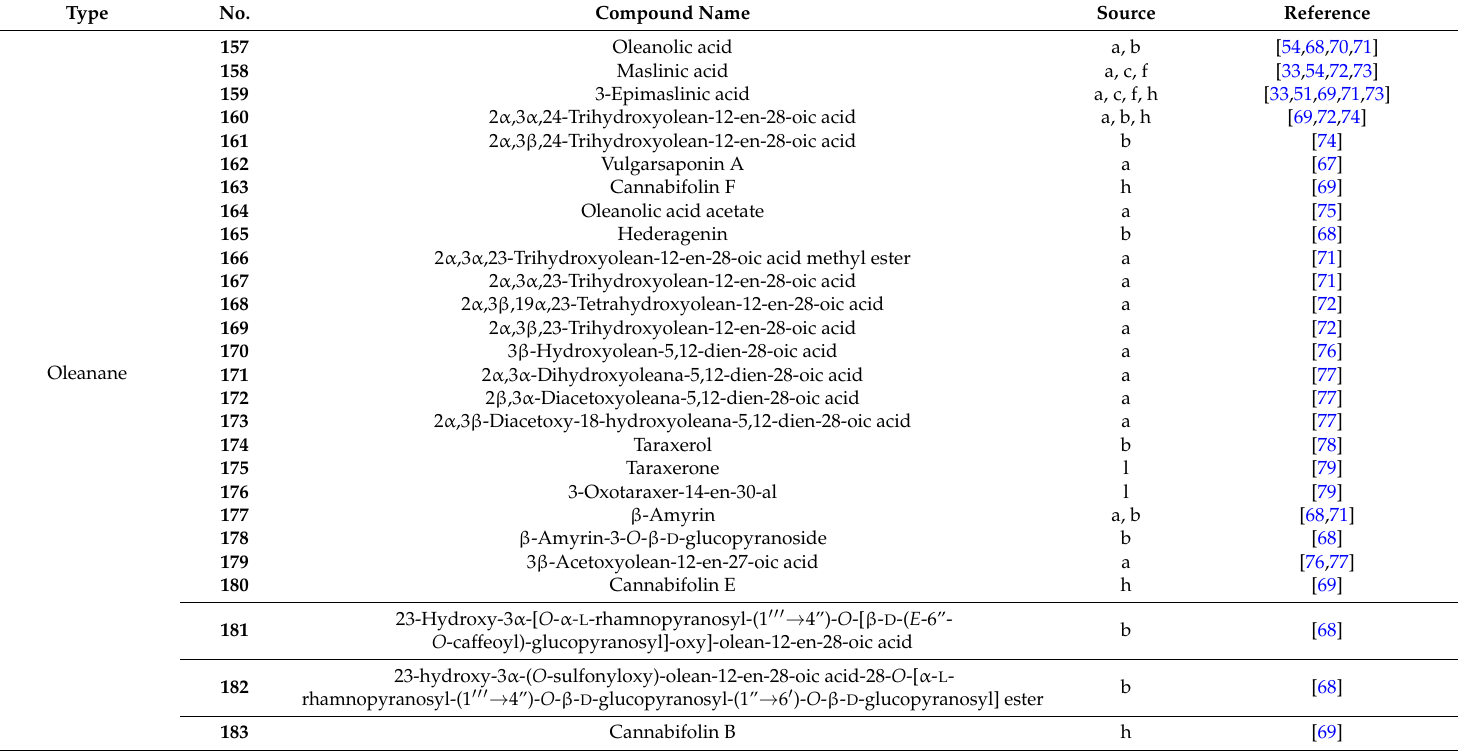
Table 4. Triterpenoids 157 – 210 isolated from plants of Vitex